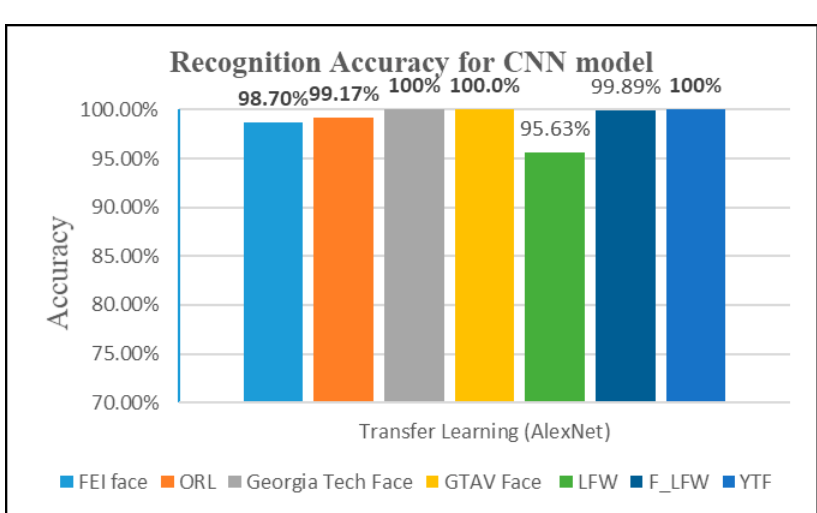
Figure 10. Accuracy for CNN models.